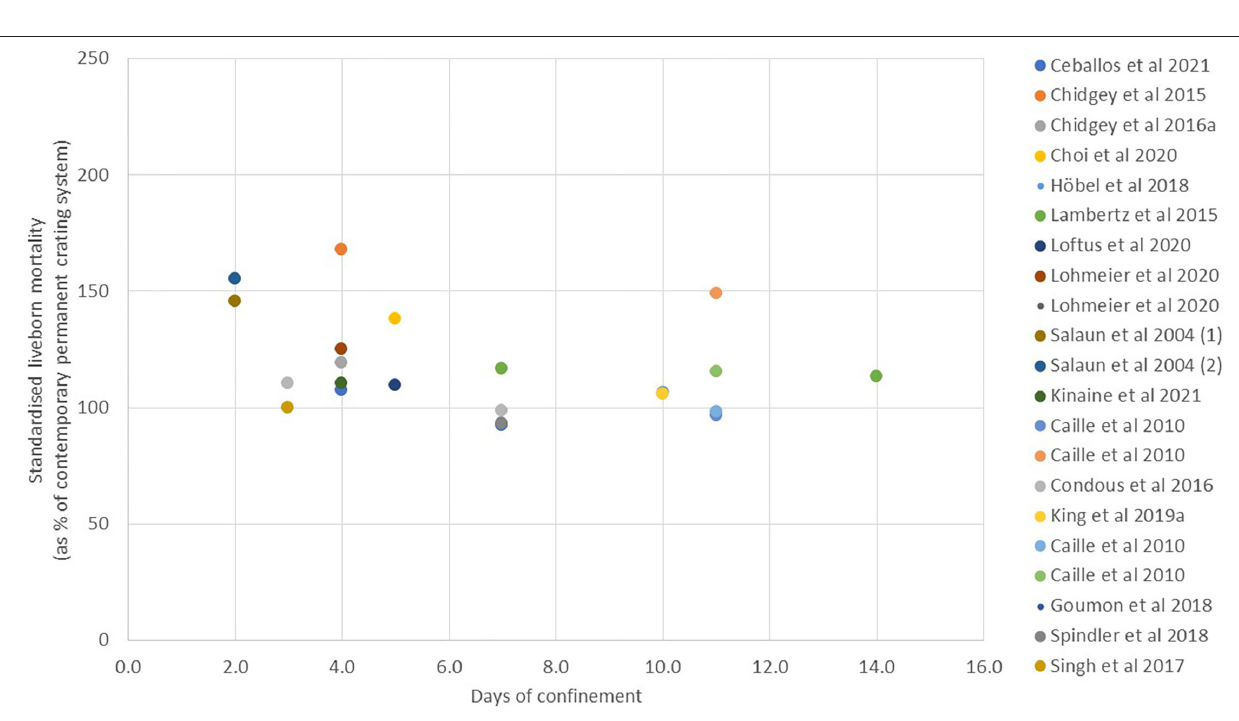
FIGURE 3 | Liveborn mortality in temporary crating systems from birth to weaning compared to systems with permanent crating (values are given as the reported mean for temporary crating when expressed as a % of the contemporary permanent crating treatment). decreasing mortality as duration of confinement increases (slope of the studies was this statistically significant due to high variation of standardized mortality against day of − 2.45 + /– 1.18, R-sq and relatively small sample sizes. A linear regression based 0.177, p = 0.051). However, this appears mainly attributable on available standardized values gives a trend line indicating